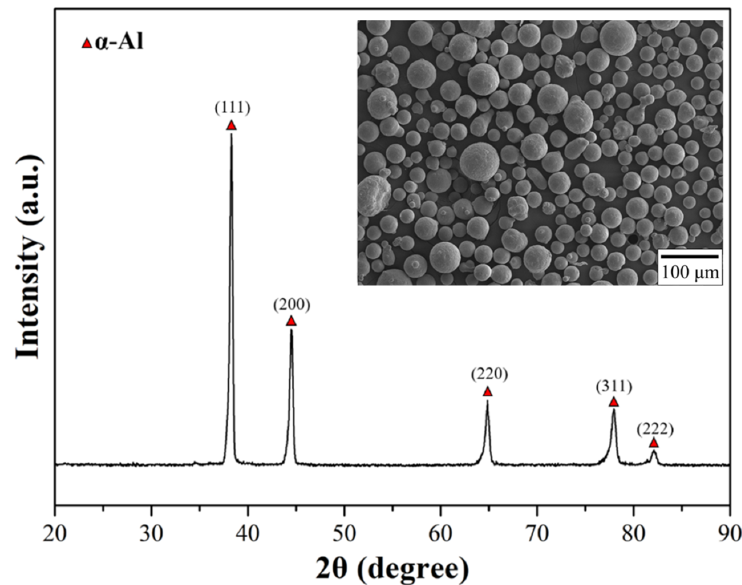
Figure 1. SEM and XRD analysis of the Al–Mg–Sc–Zr powders.